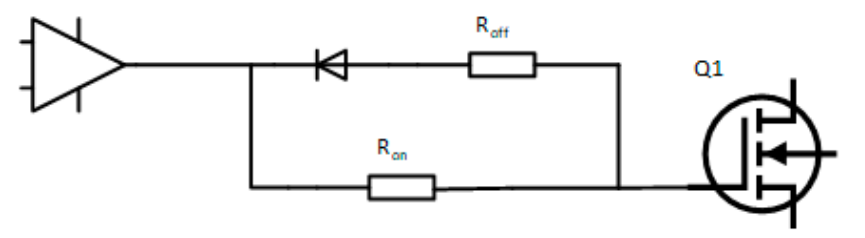
Figure 6. Configuration of the turn-on and turn-off resistors.